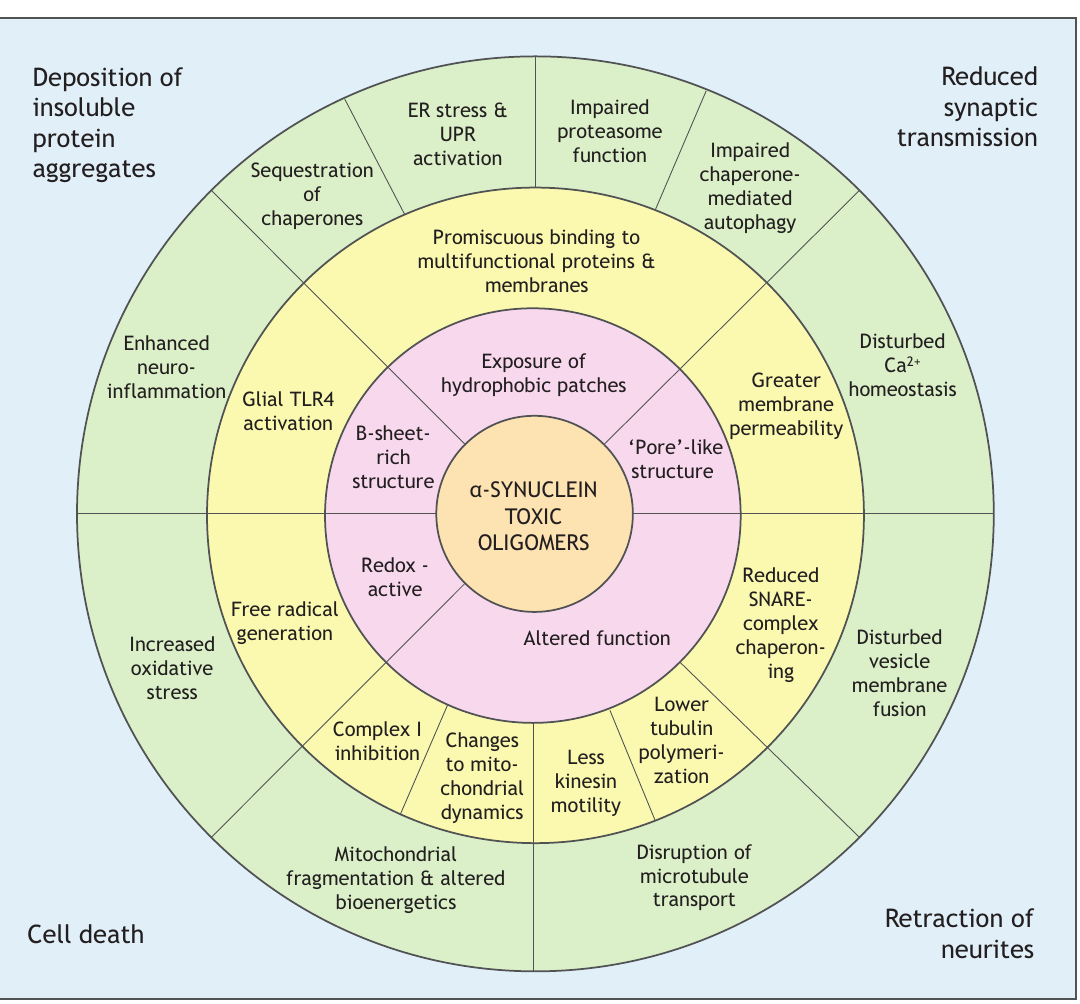
Figure 2. Cellular effects of (cid:2)-synuclein toxic oligomers, and potential links to oligomer properties. Inner shell : proposed properties of toxic oligomers. Middle shell : examples of molecular effects conferred by toxic oligomers. Outer shell : cellular systems disrupted by toxic oligomers. Edges of the box : pathological outcomes of neuron dysfunction. ER—endoplasmic reticulum. UPR—unfolded protein